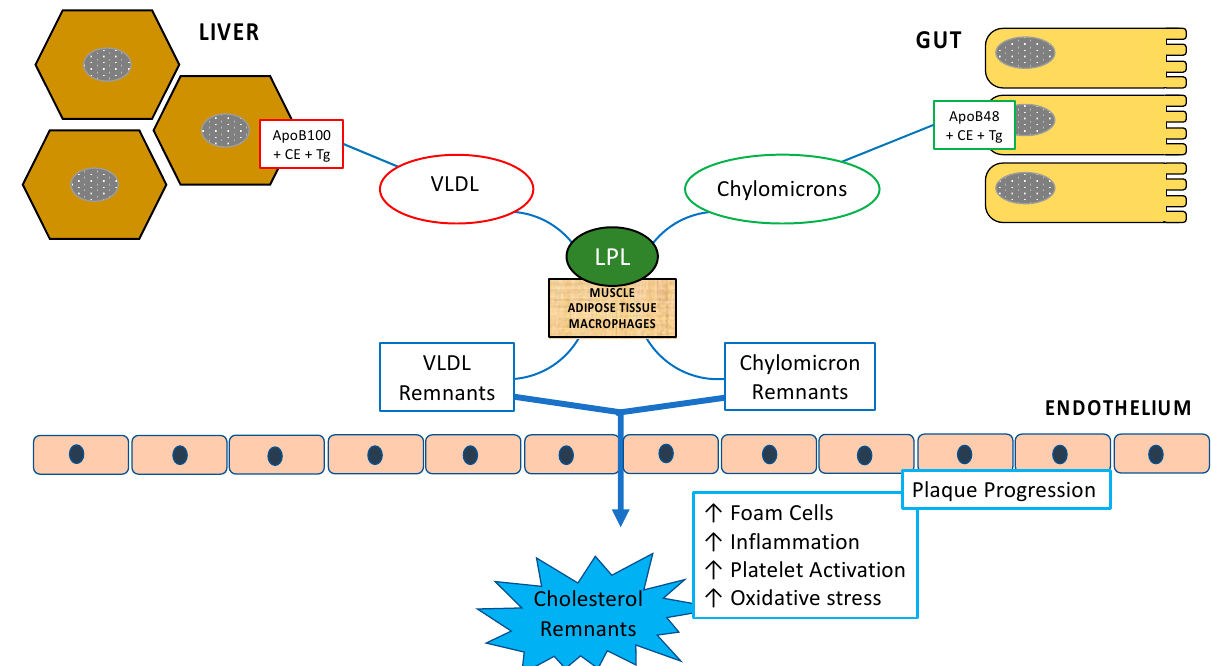
Figure 1. Remnants of cholesterol and atherosclerosis: During the post-prandial period, enterocytes produce chylomicrons which are released into the circulation via the intestinal lymphatic system. In the liver, regardless of meals, hepatocytes synthesize and release VLDL into the general circulation. Circulating and tissue lipoprotein lipases (LPL) hydrolyse VLDL and chylomicron triglycerides, transforming them into VLDL/IDL remnants and chylomicron remnants, respectively. Due to their small size, remnants easily penetrate the arterial wall and accumulate in the sub-endothelium causing inflammation, foam cells formation, platelet activation and oxidative stress leading to plaque progression.